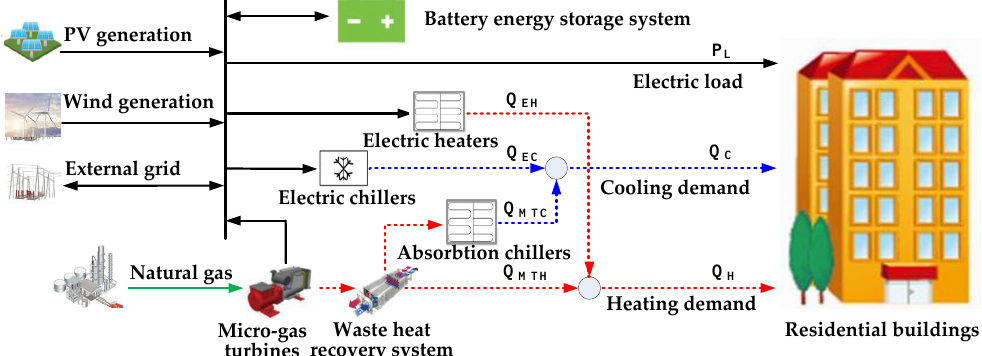
Figure 1. Structure of the studied RR-microgrid.